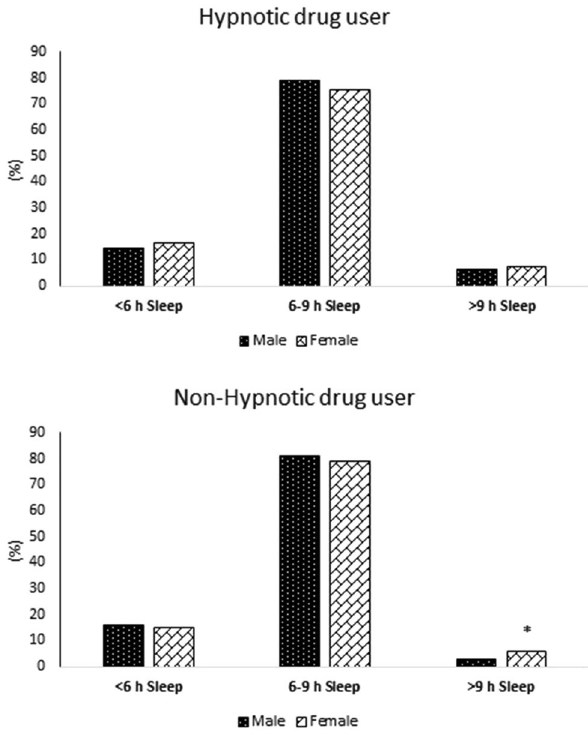
Figure 1. Prevalence of sleep duration in male and female participants based on the use of the hypnotic drugs or not. *P <